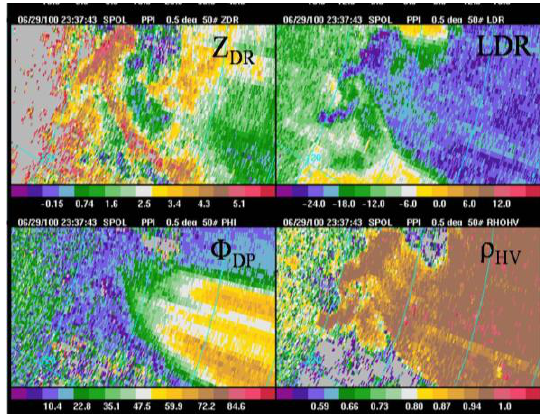
Figure 7 . A Typical indication of mentioned variables